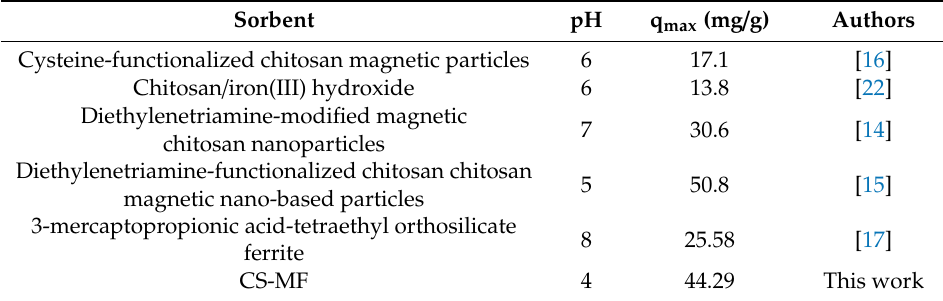
Table 3. Nd(III) recovery with di ff erent materials.